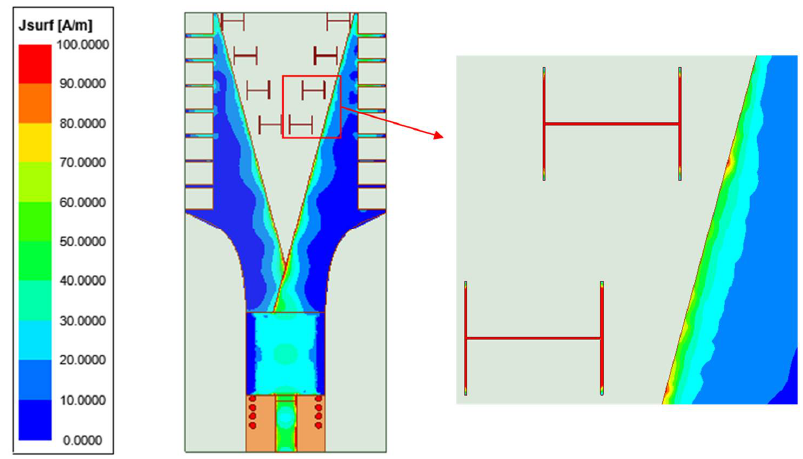
Figure 6. The current distribution of the proposed antenna.